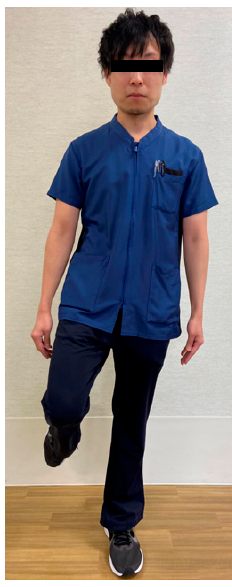
Figure 2. Static balance test.